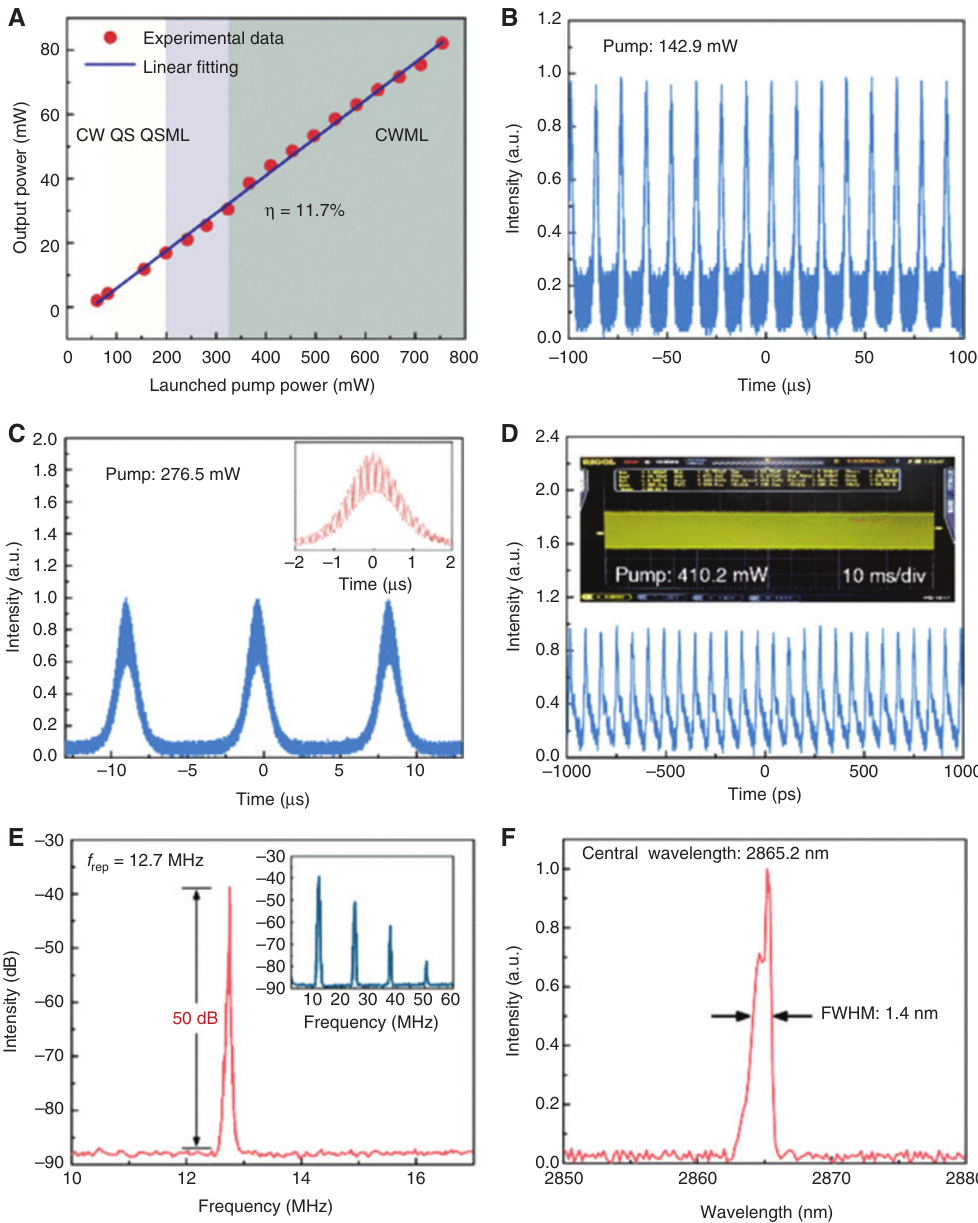
Figure 17: (A) Output power at 2.87 μ m from the CNT SA mode-locked Ho,Pr:ZBLAN fiber laser versus the pump power. CW – Continuous wave, QS – Q-switching, QSML – Q-switching mode-locking, CWML – Continuous-wave mode-locking. (B) The stable Q-switched pulses train, (C) The simultaneous Q-switching mode-locking regime, inset: the temporal pulse profile; and (D) stable mode-locking pulse train, inset: CW pulse train over a time span of 140 ms. (E) RF spectrum and (F) optical spectrum of the CWML pulses. Wei et al. [70]. © IEEE